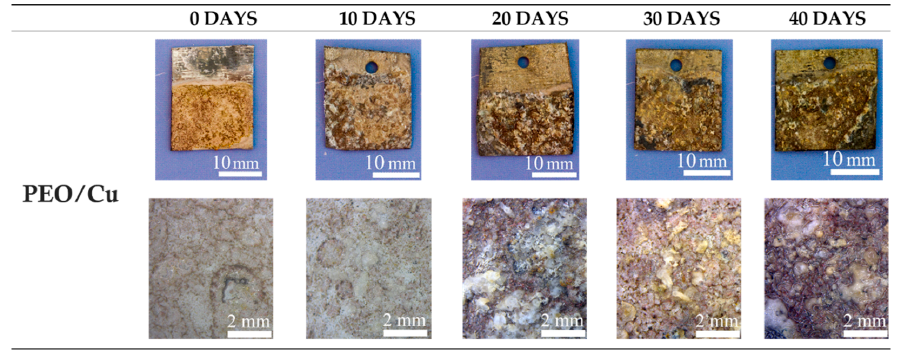
Figure 13. Visual observation (on the upper part) and stereo-microscope observation (on the bottom part) of the PEO treated samples with copper particles (1A UP small part) samples after 0, 10, 20, 30 and 40 days of immersion in circulating seawater at the Umberto D’Ancona hydrobiological station.